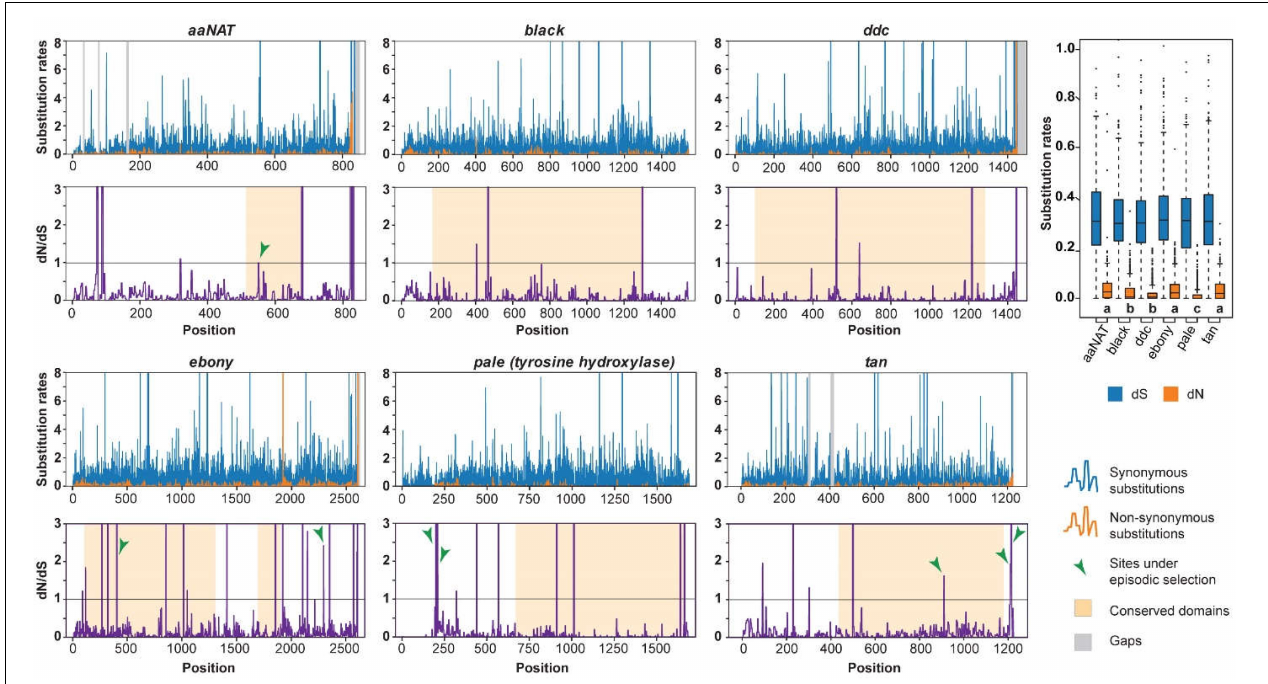
FIGURE 2 | Molecular evolution of selected genes in the melanin pathway. Molecular evolution is shown with individual rates of synonymous (blue) and non-synonymous substitutions (orange) for each codon (top panels) and dN/dS ratios for individual codons (lower panels). Functional domains for each gene are highlighted along with sites under episodic diversifying selection (green arrows, see Supplementary Table S4 ). Rates of substitutions are compared between genes in the boxplot (right) where dN values significantly differ across genes ( p < 0.001, see Supplementary Table S3 ). Groups that do not differ statistically are represented by the same